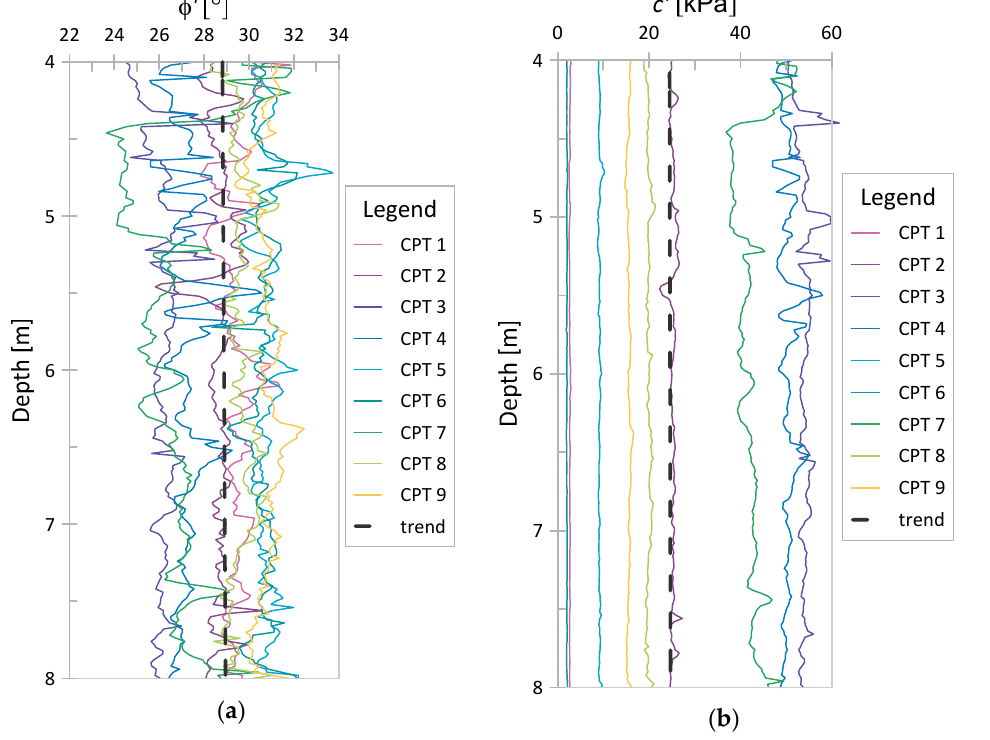
(cid:48) ; ( b ) c (cid:48) .